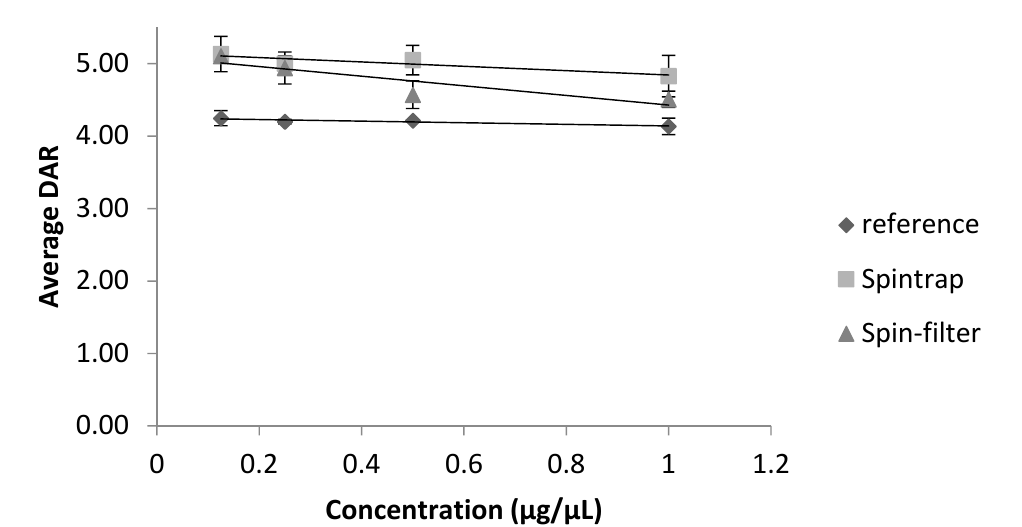
Figure 5. Apparent DAR-values of vcMMAE–trastuzumab depending on sample concentration prior to injection and effect of sample desalting. Error bars depict the standard deviation from triplicate measurements for each sample.